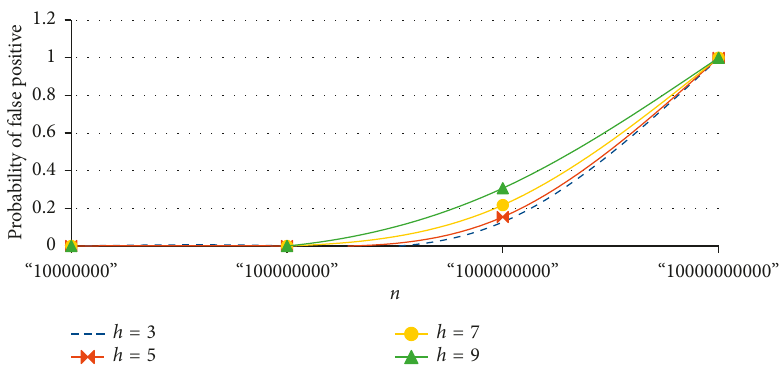
3 that illustrates the true positive, false positive, and true (cid:31)